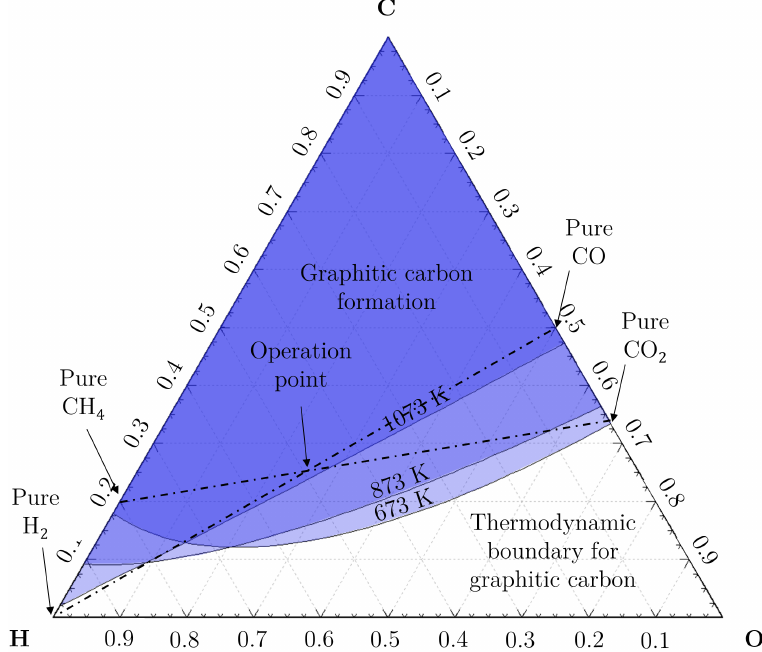
Figure 3. Ternary diagram for characterization of coke formation tendency in dry reforming experiment at a CH 4 /CO 2 ratio of 1:1, graphitic carbon boundaries calculated using FactSage.